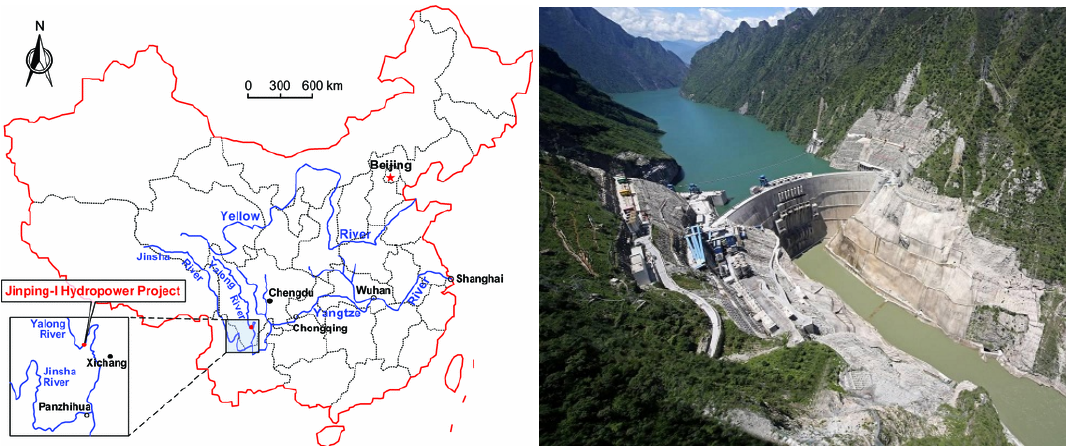
A sketch map for the geographical location of Jinping-I Hydropower Station and its design